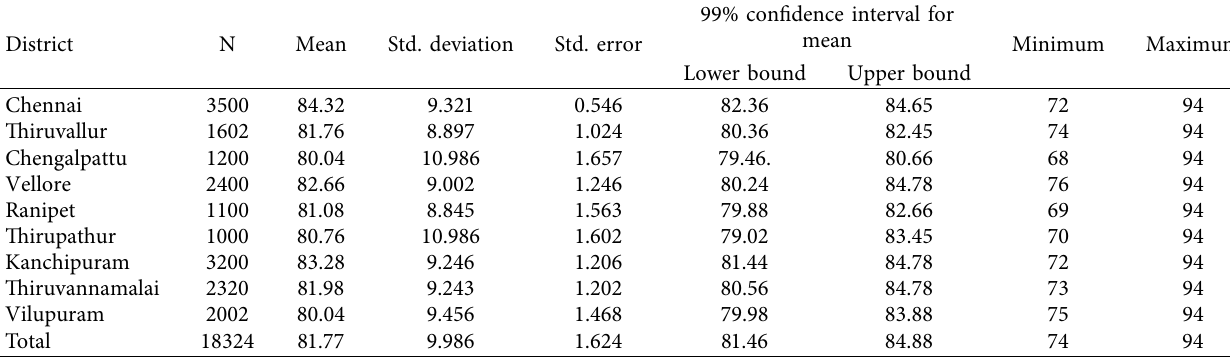
Table 2: Results of descriptive statistics for personality development qualities in Madras group. District